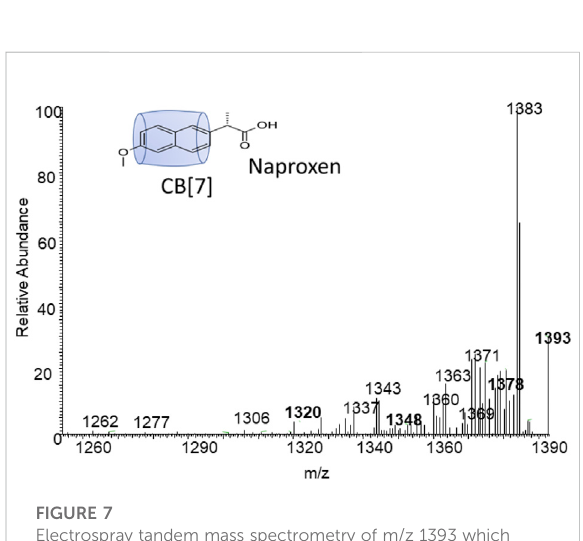
FIGURE 7 Electrospray tandem mass spectrometry of m/z 1393 which represent the mass of the naproxen-CB7 complex.